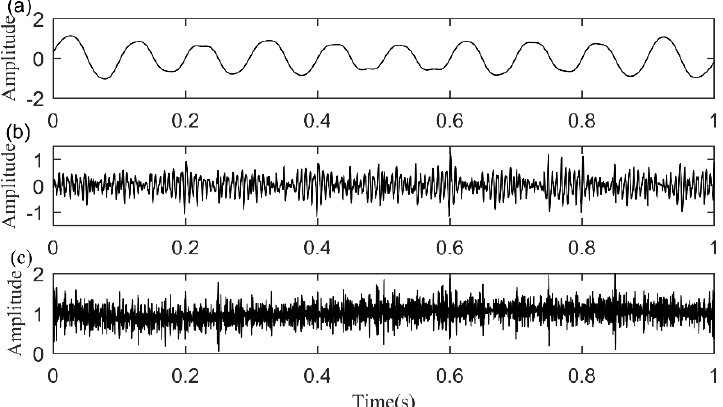
Figure 4. Decomposition results x 1 ( t ) by EEMD. ( a ) Square wave components corresponding to IMF; ( b ) IMF corresponding to the AM – FM sine component. ( c ) Noise component.